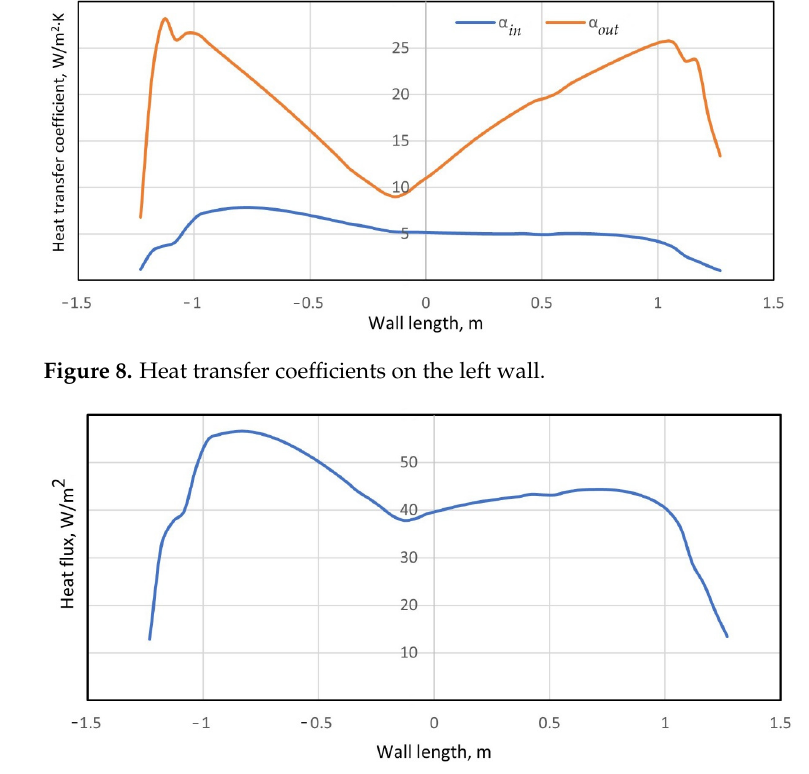
Figure 10. Heat transfer coefficients on the top wall.